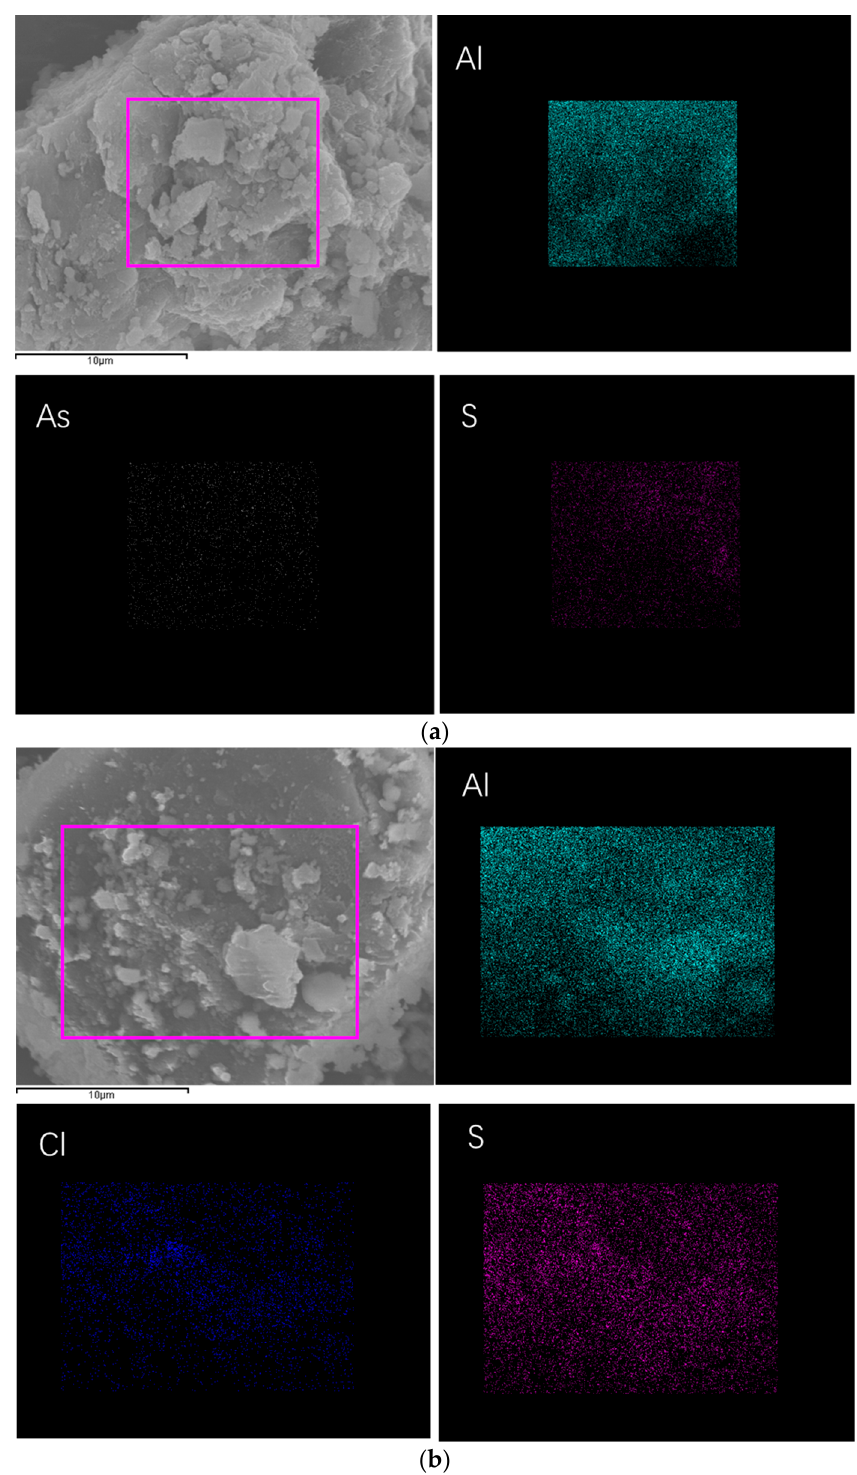
Figure 6. Elemental mapping results of CATs poisoned by As ( a ) and Cl ( b ).